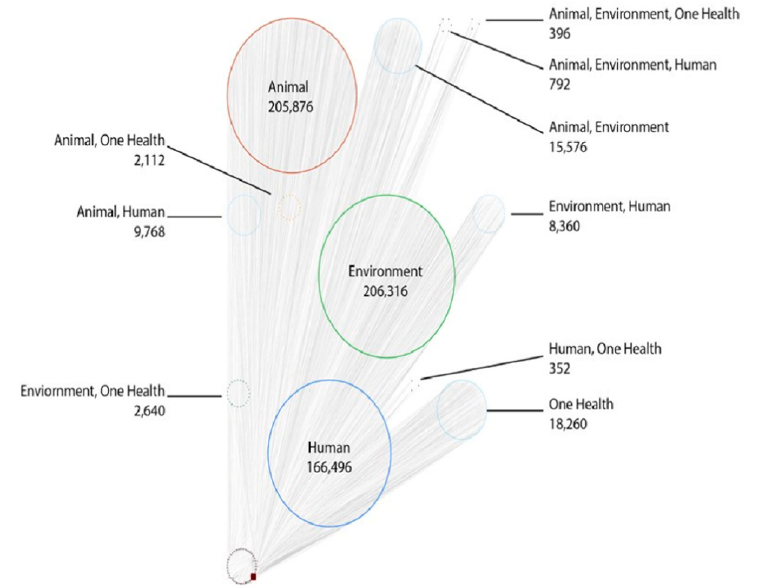
Figure 1. Network of the similar and/or dissimilar language usage among One Health groups. The Group Attributes Network Layout groups articles into bins and places each bin on the graph in relation to how similar the bins are to one another. Each bin represents different combinations of search terms found in the articles’ titles and abstracts. For instance, the Human group are articles that exclusively used human-binned terms in their title or abstract. Larger groups (and group counts) indicate the number of articles within that group. Bins plotted closer together share similar patterns of term frequency and usage within the articles’ body. The number within each circle indicate how many occurrences of those terms occurred in the articles (i.e., the terms in the human term bin occurred 166,496 times in the articles that exclusively used human terms in their title and abstracts).